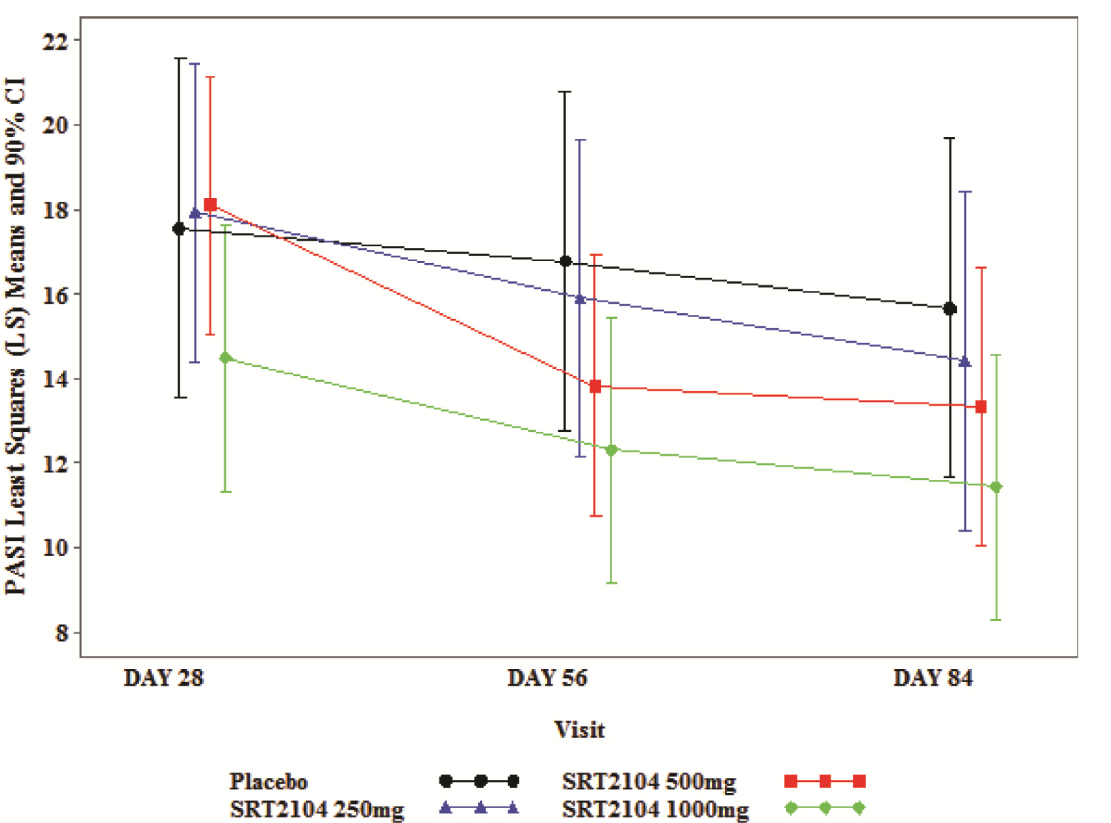
Fig 2. Plot of LS Mean (+/- SE) PASI Total Score vs.